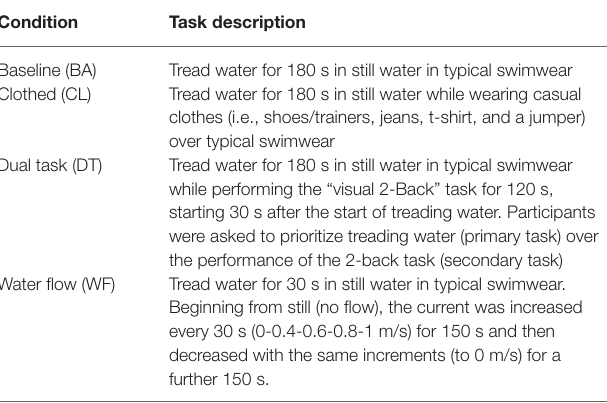
TABLE 1 | Descriptions of the experimental